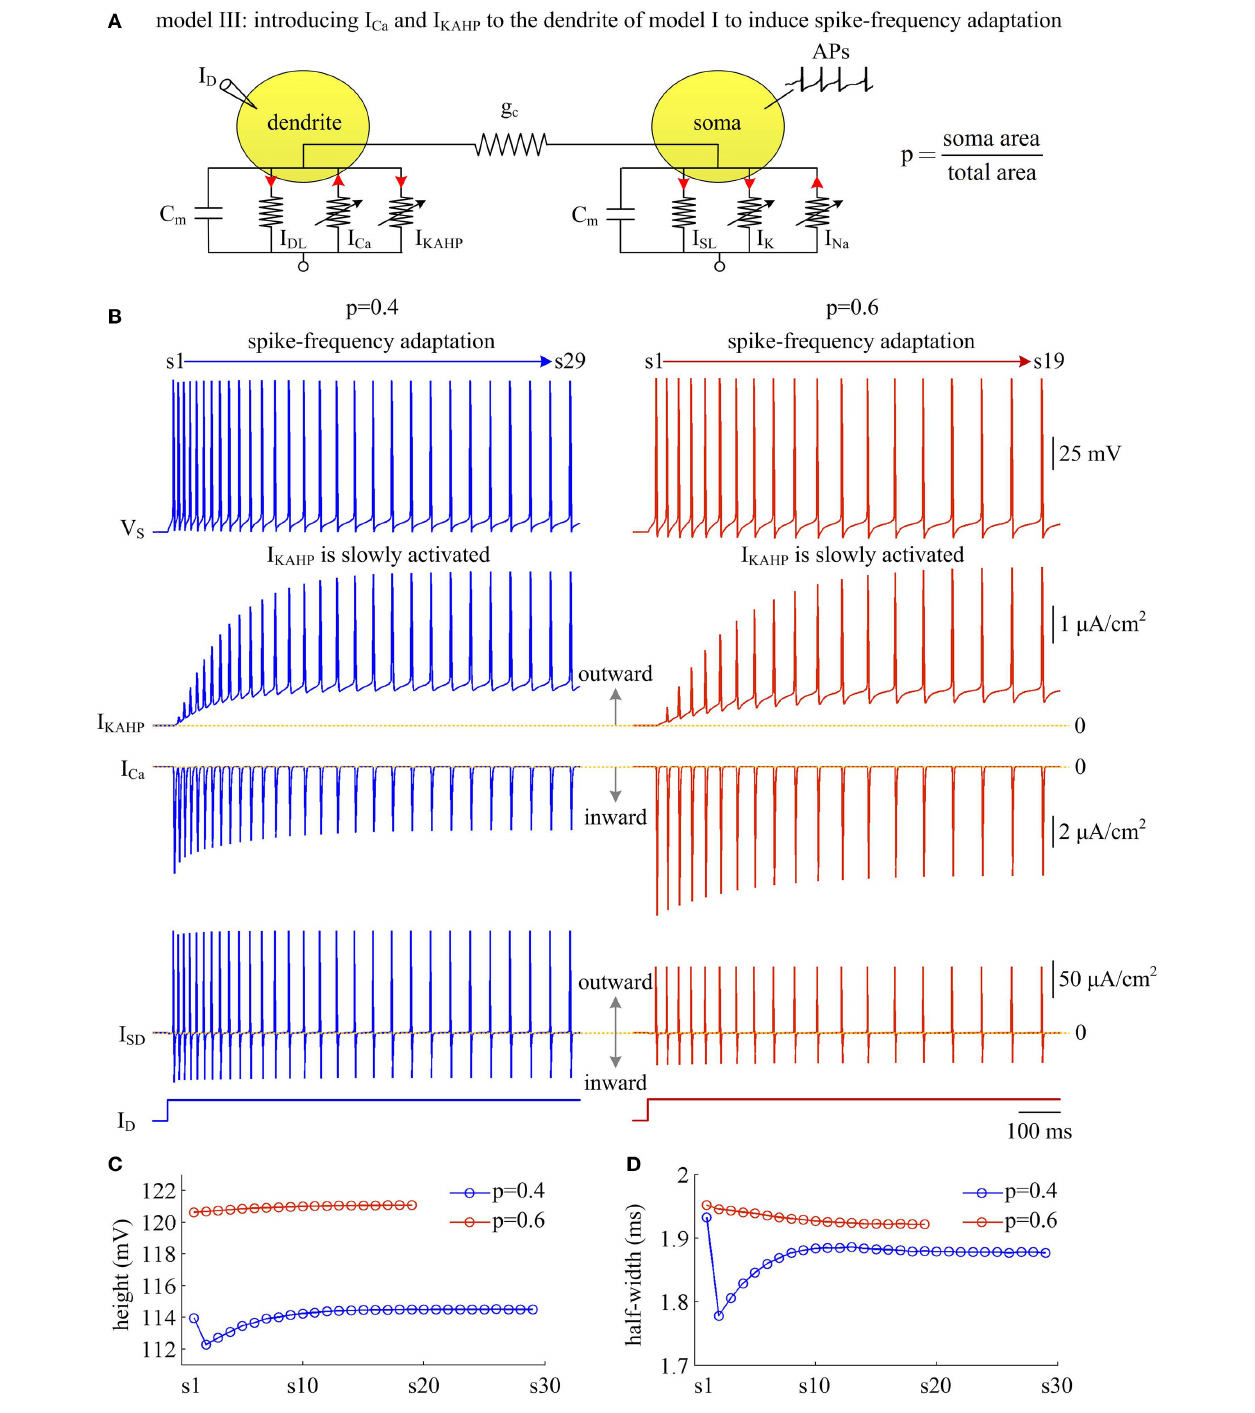
FIGURE 9 | Activating I KAHP in dendritic chamber results in SFA in model III. (A) Schematic of model III. An inward Ca 2 + current I Ca and a Ca 2 + -activated outward K + current I KAHP are introduced to the dendritic chamber of model I. (B) Sample responses recorded in the soma with p = 0.4 and 0.6. V S , I KAHP , I Ca , and I SD are plotted against time. With p = 0.4 (left), there are 29 APs generated during the interval of 1,000 ms, and we number them s1 through s29 from left to right. With p = 0.6 (right), there are 19 APs during the interval of 1,000 ms, and we number them s1 through s19 from left to right. As I KAHP is activated, the firing rate decays down to a lower steady-state level, and model III neuron generates SFA. (C) The height of each AP with p = 0.4 and 0.6. (D) The half-width of each AP with p = 0.4 and 0.6. I D = 2 µ A / cm 2 and g c = 0.6 mS / cm 2 .